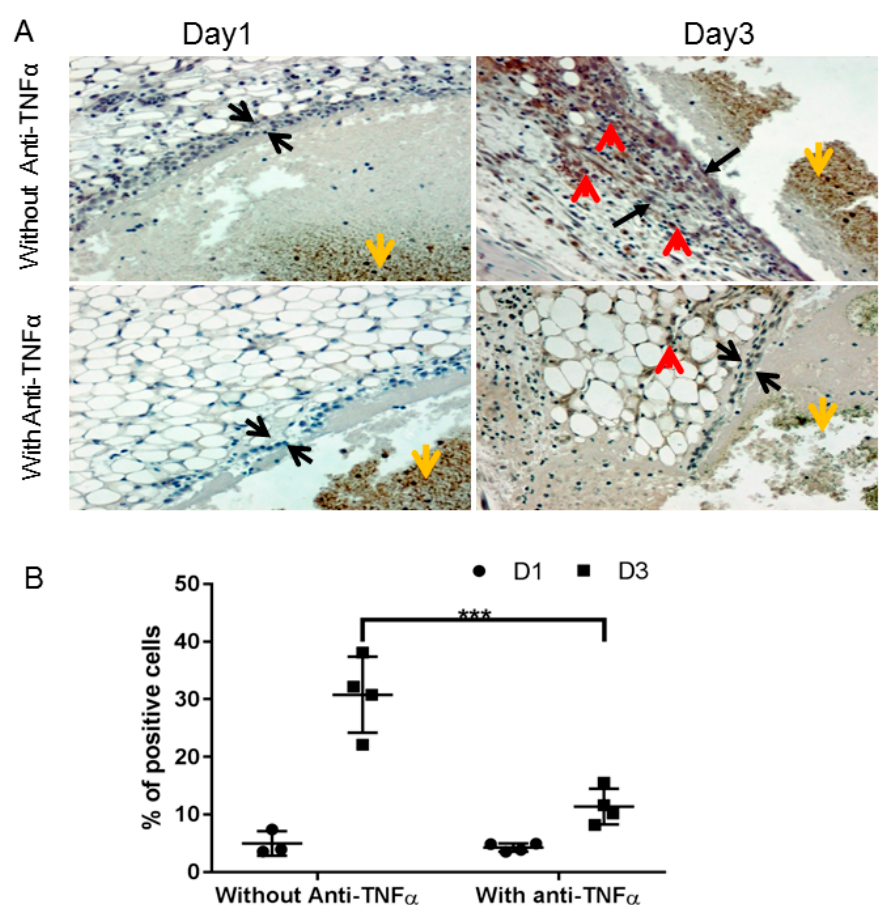
Figure 4. Anti-TNF α decreased macrophage infiltration / proliferation into the synovium. ( A ): FIX − / − mice were pre-treated with 5 doses of etanercept 5 mg / kg s.c., as described in Figure 1A (“With Anti-TNF α ”); mice in control group were treated with normal saline (“Without Anti-TNF α ”). Hemarthrosis was induced by needle injury on the left knee joint. Days 1 and 3 after hemarthrosis induction, the treated knee joint was collected for macrophage immunochemistry staining as described in Methods. Black arrow represents the synovial lining; red arrow depicts positive macrophage staining; and yellow arrow represents the flesh blood hemorrhage in the joint space. ( B ): Quantitative analysis, percentage of positively stained cells, were performed by counting of cells in synovium. *** p < 0.01.